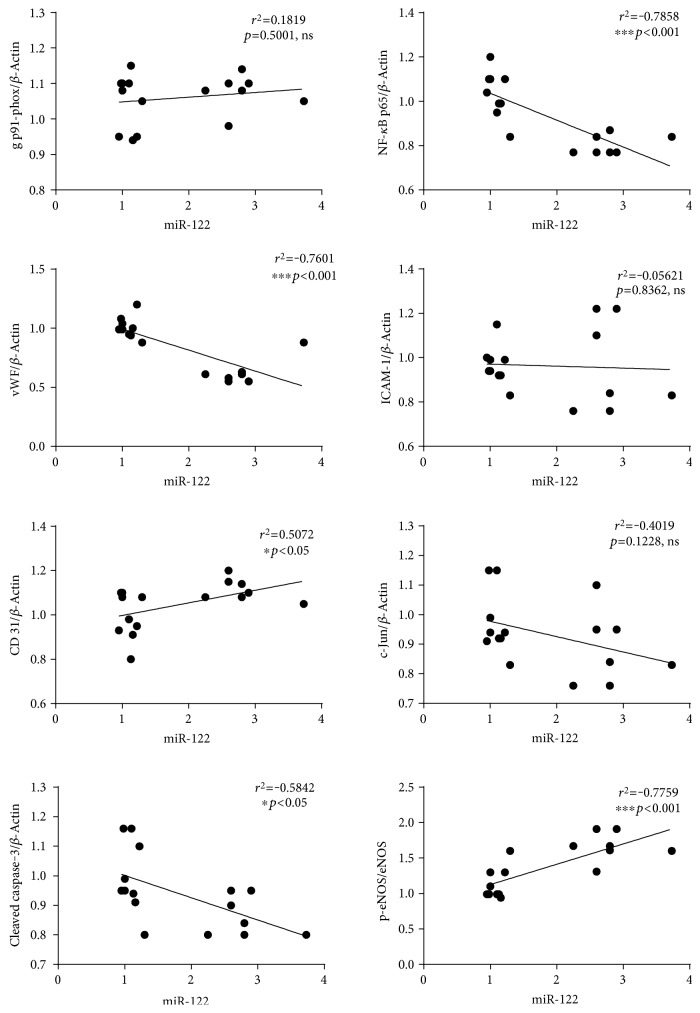
Correlation analysis between miR-122 and protein expression levels in the SHRSR strain. Scatter plots showing the results of the correlation analysis between miR-122 expression level and each examined protein level in the brain of SHRSR.